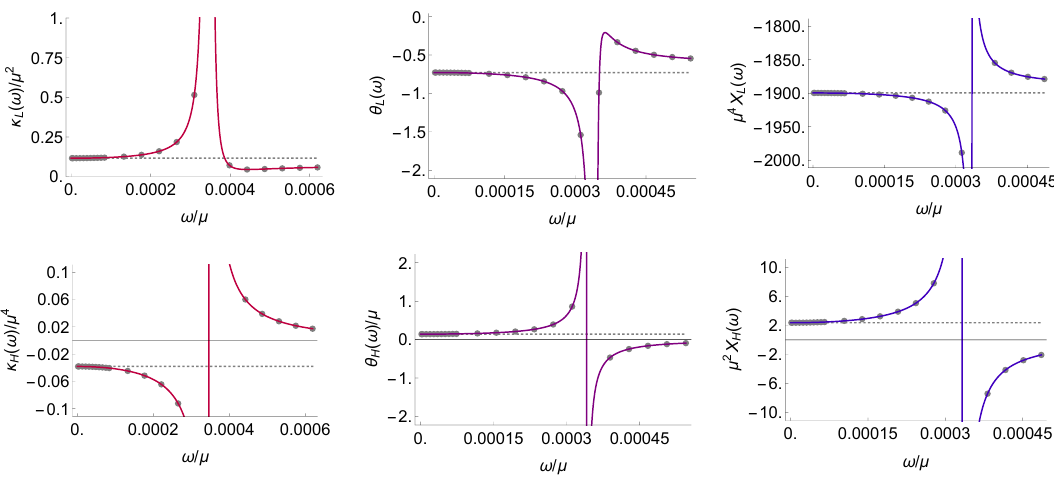
Figure 1. Spontaneous case AC correlators at k/µ = 10 − 1 . Grey dots are numerical data, solid lines are our analytic hydrodynamic expressions and the dashed grey line is the DC value of the coefficient. Left column: the thermal conductivities ( κ ( ω ) ) at T/µ = 0 . 06 and B/µ 2 ≈ 4 . 4 × 10 − 4 . Central column: the heat-Goldstone correlators ( θ ( ω ) ) at T/µ = 0 . 04 and B/µ 2 ≈ 3 . 9 × 10 − 4 . Right column: the Goldstone-Goldstone correlators ( X ( ω ) ) at T/µ = 0 . 02 and B/µ 2 ≈ 3 . 5 × 10 − 4